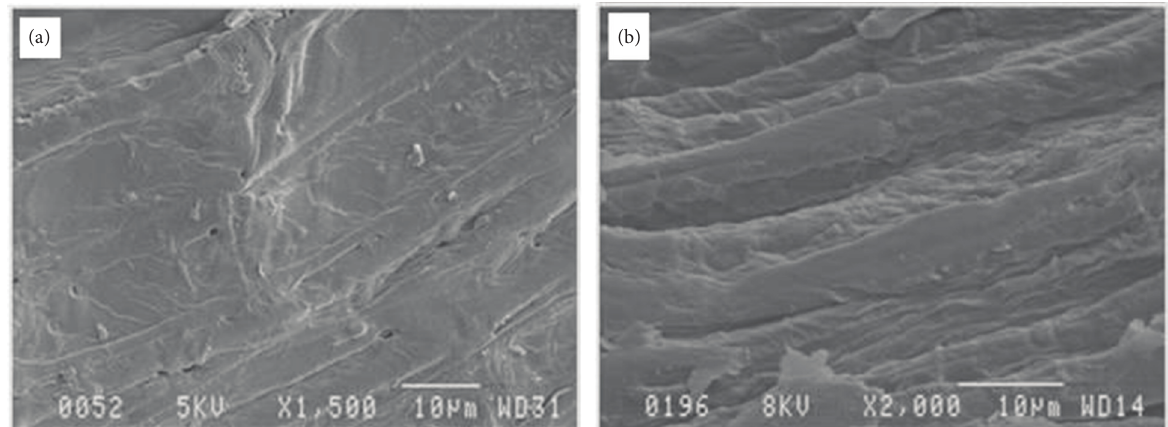
Figure 5: SEM images of untreated (a) and alkali-treated (4hr) (b) Borassus fruit fine fibers [28].